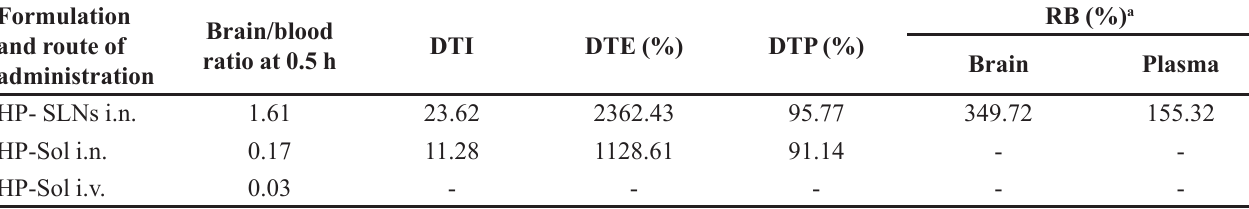
TABLE VII - Results of brain/blood ratio at 0.5 h, DTI, DTE (%) and DTP (%) Formulation Brain/blood and route of ratio at 0.5 h Brain Plasma administration HP- SLNs i.n. HP-Sol i.n. HP-Sol